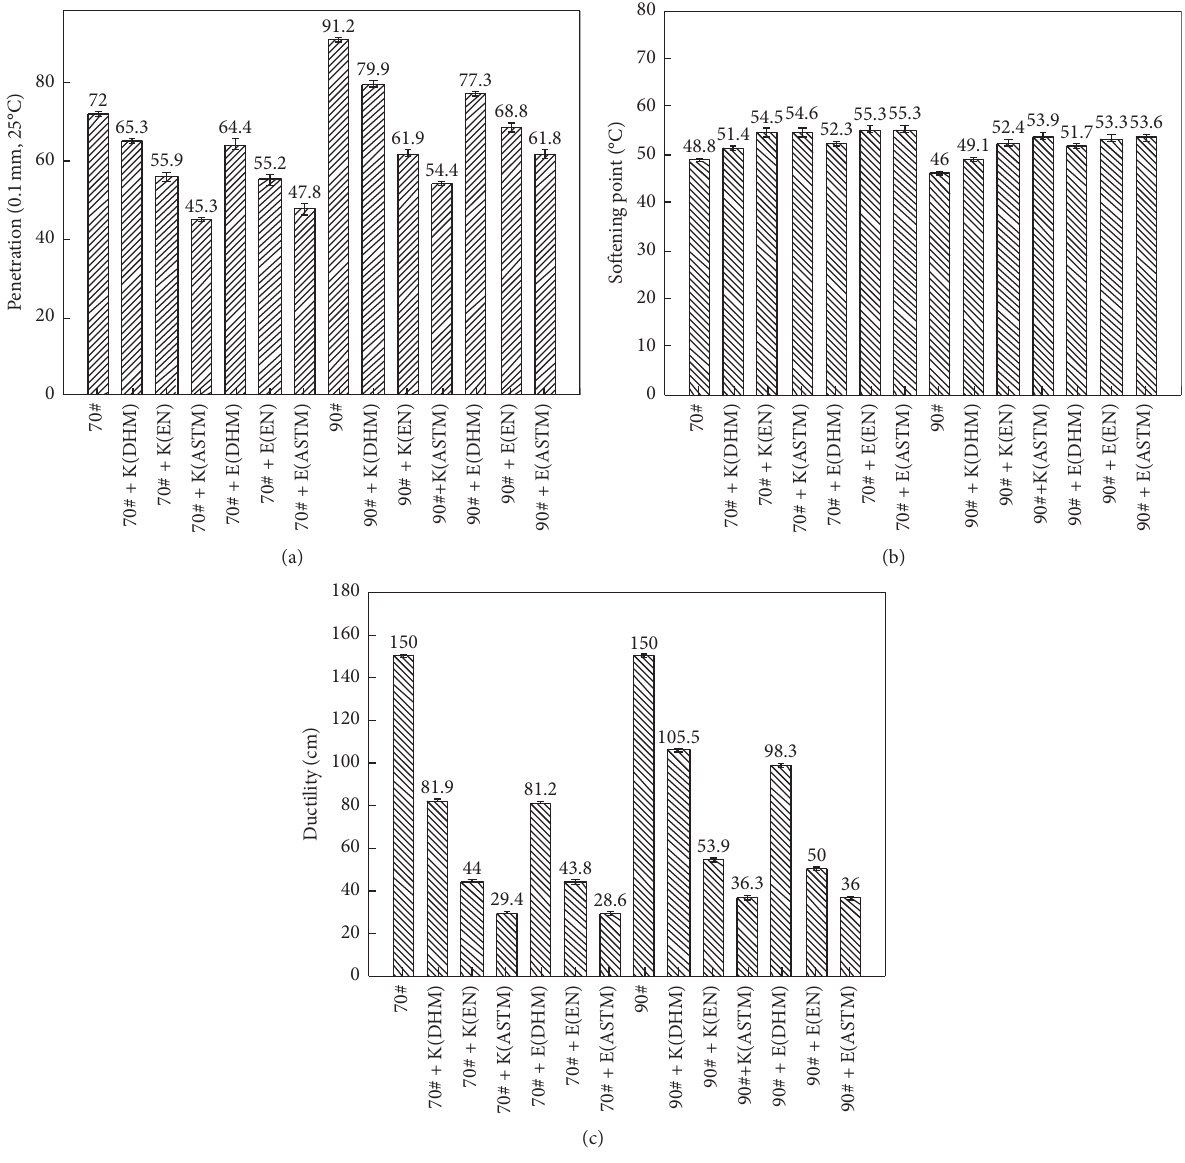
Figure 4: Performances of the emulsified asphalt